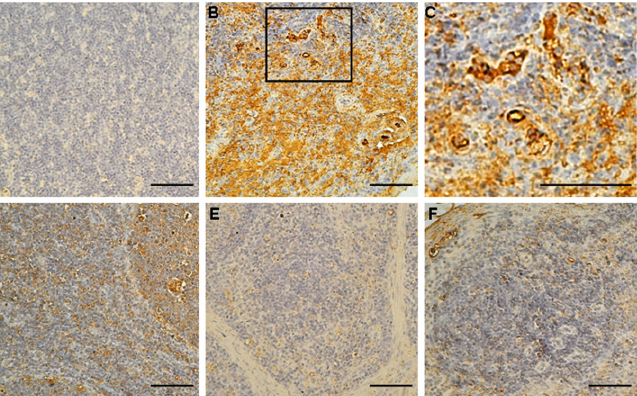
Fig 5. Immunohistochemical staining for inguinal lymph nodes of rFla-Cap vaccinated pigs after PCV2 challenge. Cells were positive for PCV2 viral antigen (brown). (A) Lymph node section from a pig of the non-vaccinated non-challenged group shows no staining for PCV2 antigen. (B) Lymph node section from a non-vaccinated PCV2-challenged pig. Many PCV2 antigen-positive cells are seen. (C) Enlargement of some areas (black square) in panel B. (D) Lymph node section from a 200rFla-Cap-vaccinated PCV2-challenged pig shows reduced amounts of PCV2-positive cells. (E) 500rFla-Cap-vaccinated PCV2-challenged pig. No staining for PCV2 viral antigen is seen. (F) Sub-Vac-vaccinated PCV2-challenged pig. A small amount of positive cells for PCV2 viral antigen are seen. Bar, 80 μ m.